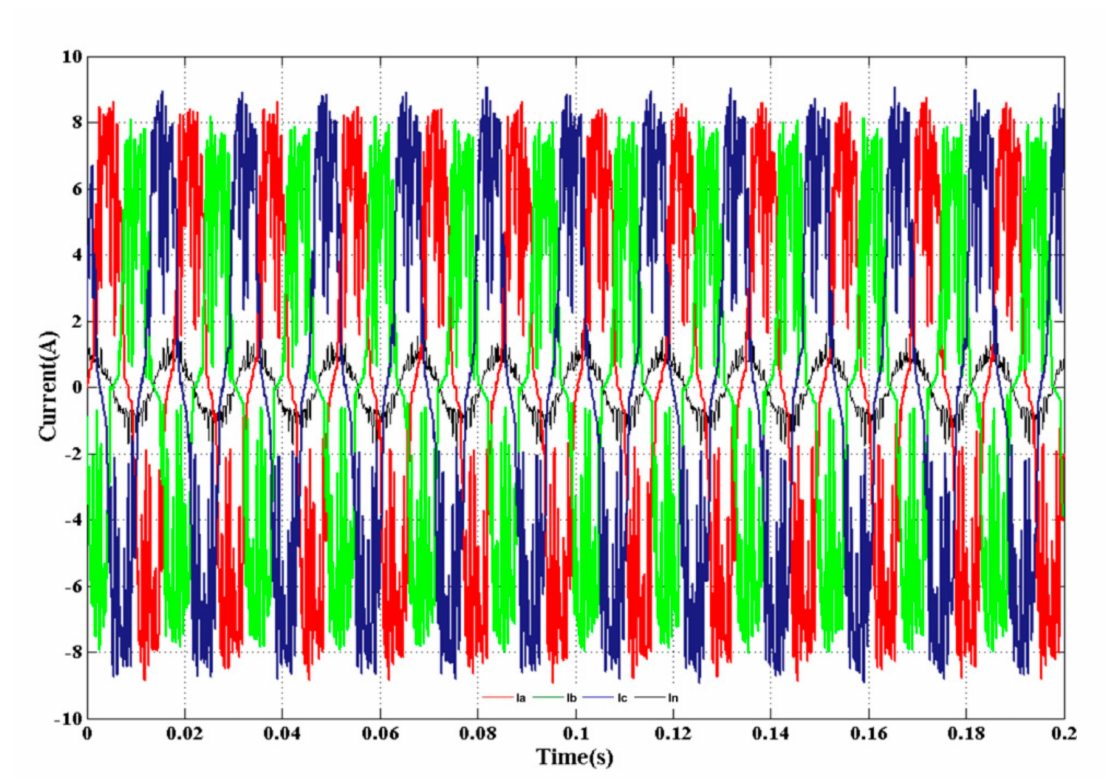
Figure 10. Source current before SAPF compensation for case 2.